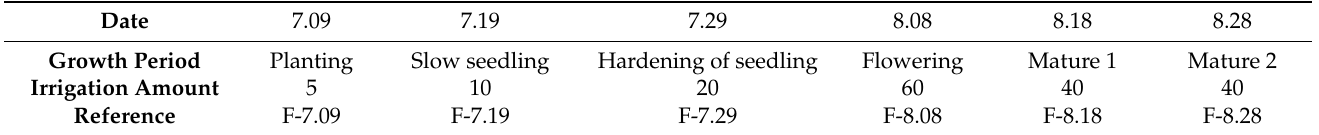
Table 2. Irrigation amount of eggplant at different growth stages (unit: